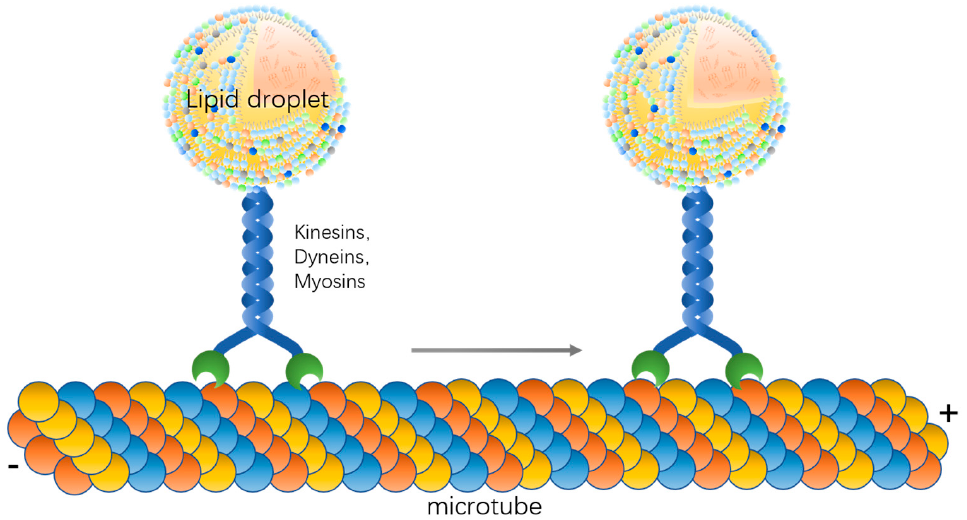
Figure 1. Lipid droplet moves along the microtube driven by motor proteins.